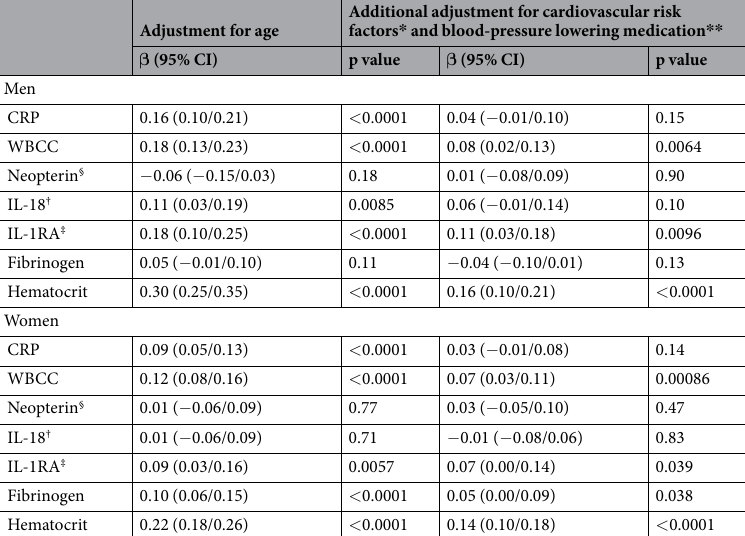
fibrinogen), as well as on the 10-year risk for incident CVD according to the updated Framingham Risk Score (FRS) (Supplemental Fig. 2, again illustrated for CRP and fibrinogen). For further evaluation of the prognostic impact on all-cause mortality, SI and each biomarker were dichoto- mized (below or equal versus above the median concentration). During the follow-up period of 6.2 ± 1.7 years,